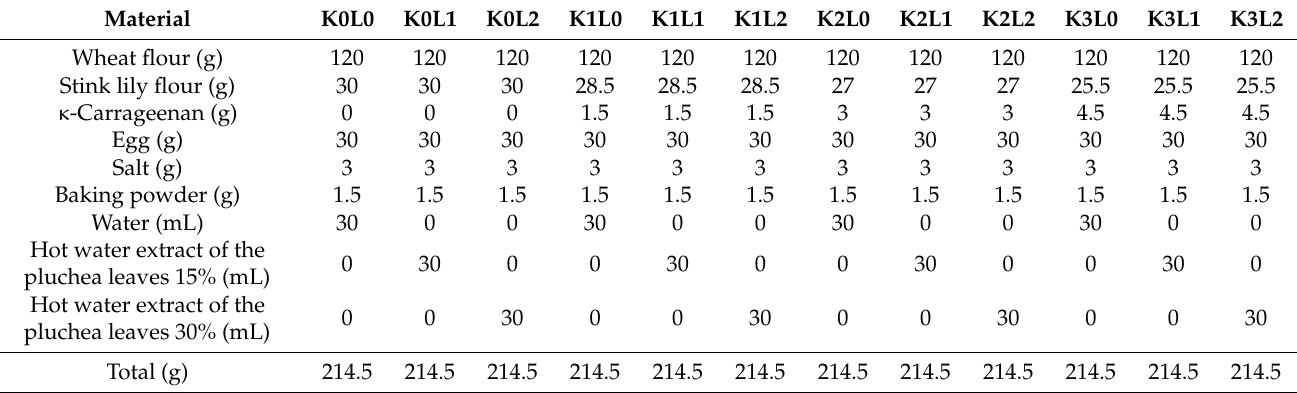
Table 2. The formula of the stink lily wet